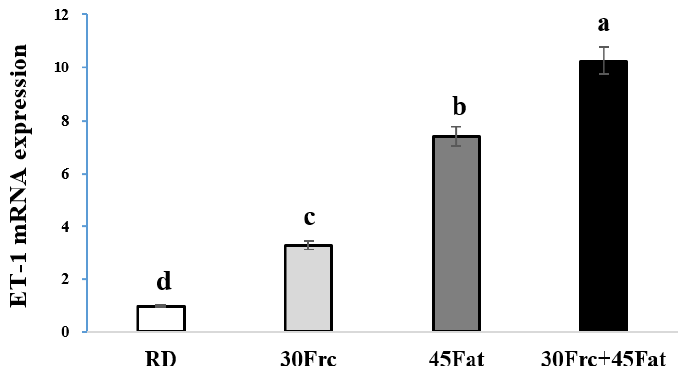
Figure 4. Aortic ET-1 mRNA expression measured by qRTPCR. RD: rats received a regular diet based on AIN-93G (4.0 kcal/g diet); 30Frc: rats received a 30% fructose-diet based on control-diet (4.0 kcal/g diet); 45Fat: rats received a 45 kcal% fat-diet (4.8 kcal/g diet); 30Frc + 45Fat: rats received a 45 kcal% fat-diet with 30% fructose (4.8 kcal/g diet). Statistical differences between the experimental groups were based on one-way ANOVA and Duncan’s multiple range tests at p < 0.05. Means with different alphabetical letters are significantly different ( p < 0.05).